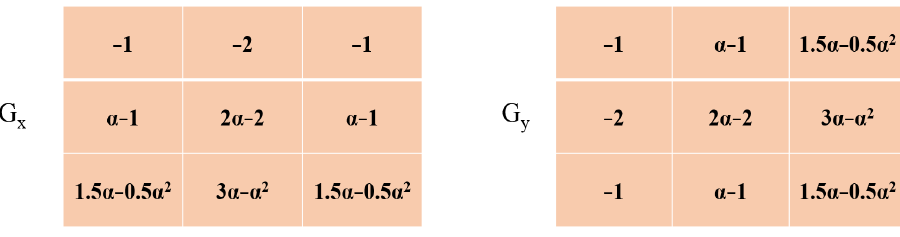
Figure 7. Right-side-oriented fractional-order masks using Sobel.